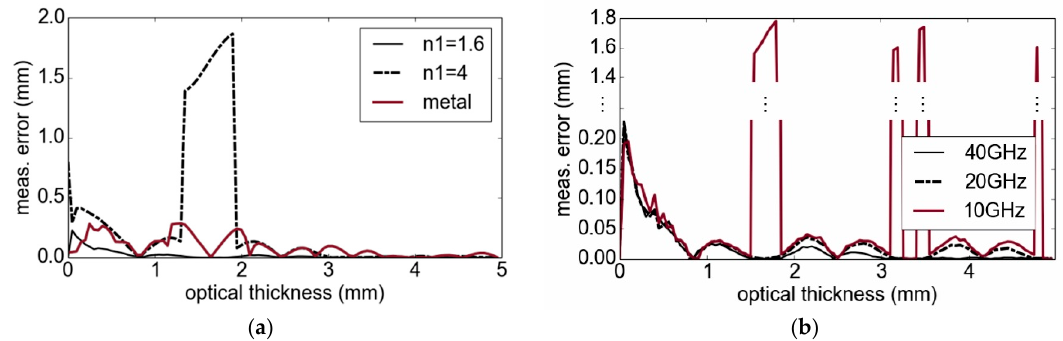
Figure 4. Thickness measurement (meas.) errors caused by disregarding multiple reflections: ( a ) dependency on refractive indices and ( b ) reduced bandwidth from 40 GHz to 10 GHz with a constant center frequency of 90 GHz.